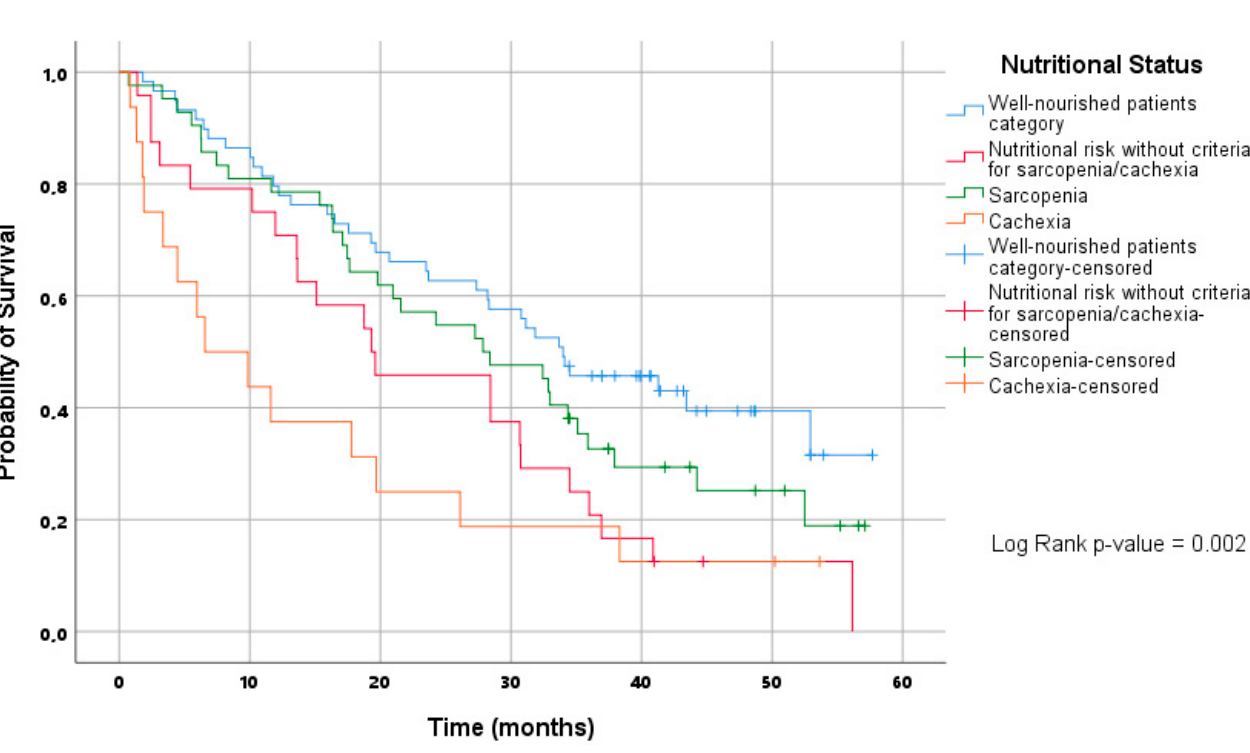
Figure 4. Kaplan Mayer curves of overall survival according to nutritional status.